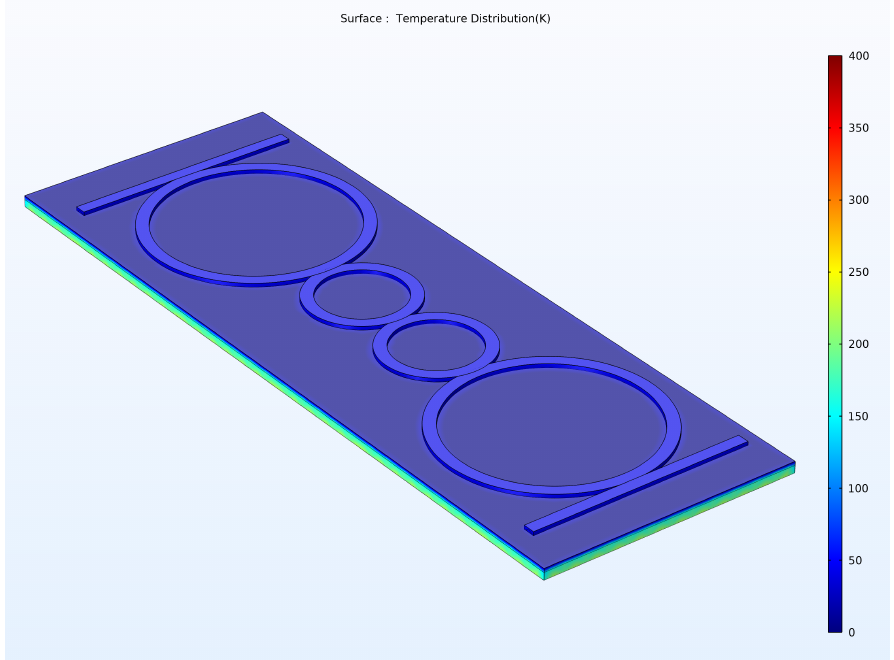
Figure 11. Temperature profile in the filter. The temperature-induced deformation did not distort the fundamental modes in the filters.